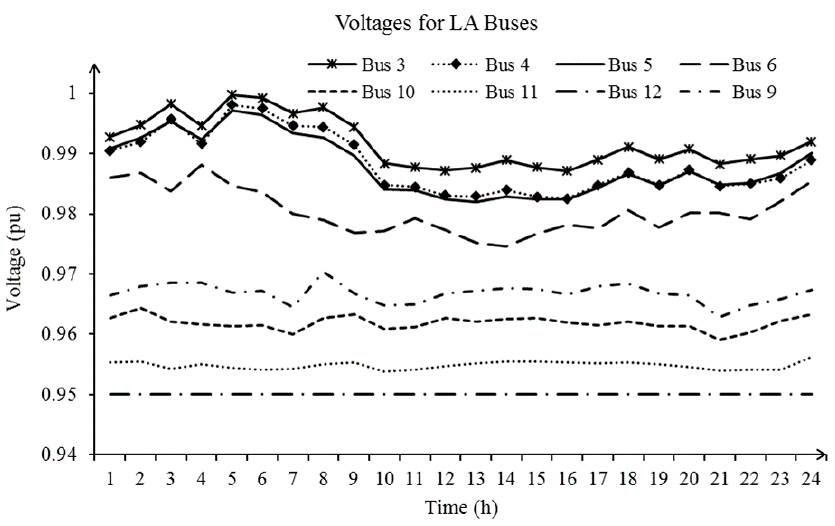
Figure 8. Voltage magnitudes for LA buses.